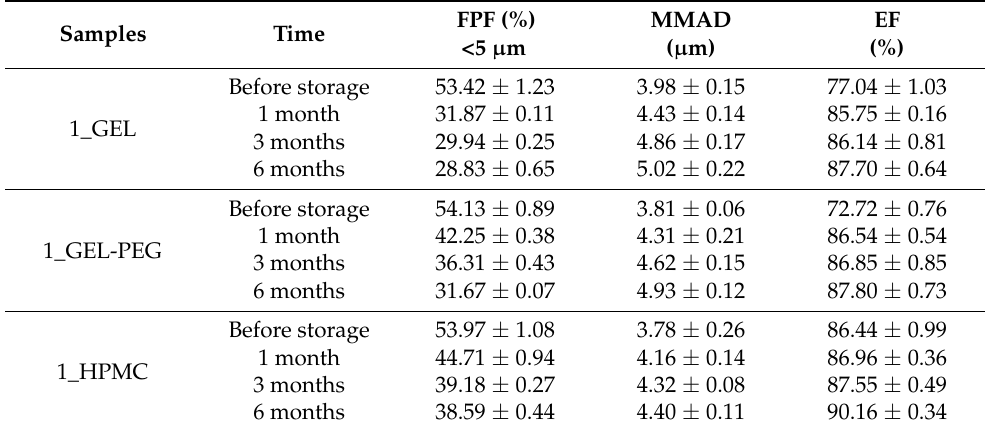
Table 7. Aerodynamic properties of the carrier-free formulations.